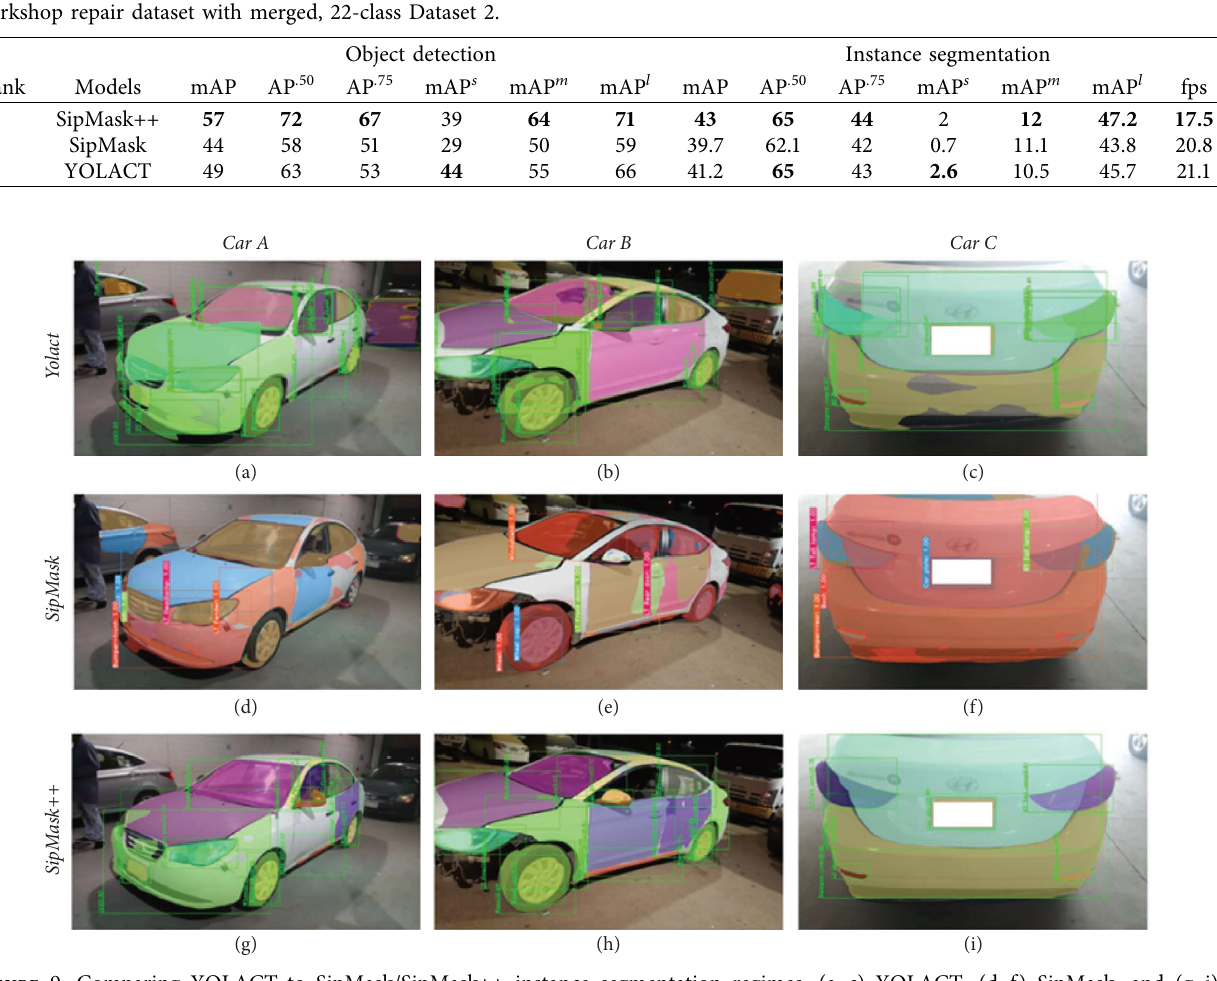
Figure 9: Comparing YOLACT to SipMask/SipMask++ instance segmentation regimes. (a–c) YOLACT, (d–f) SipMask, and (g–i)